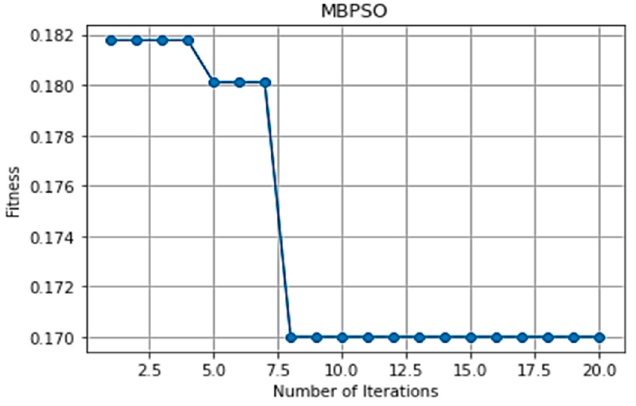
Figure 9. Feature selection of MBPSO.